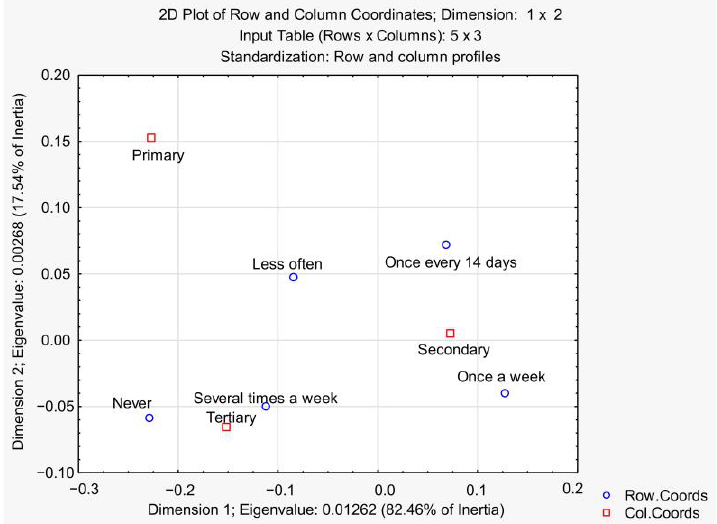
Figure 6. Correspondence maps, Hypermarkets & Respondent’s education. Source: authors.